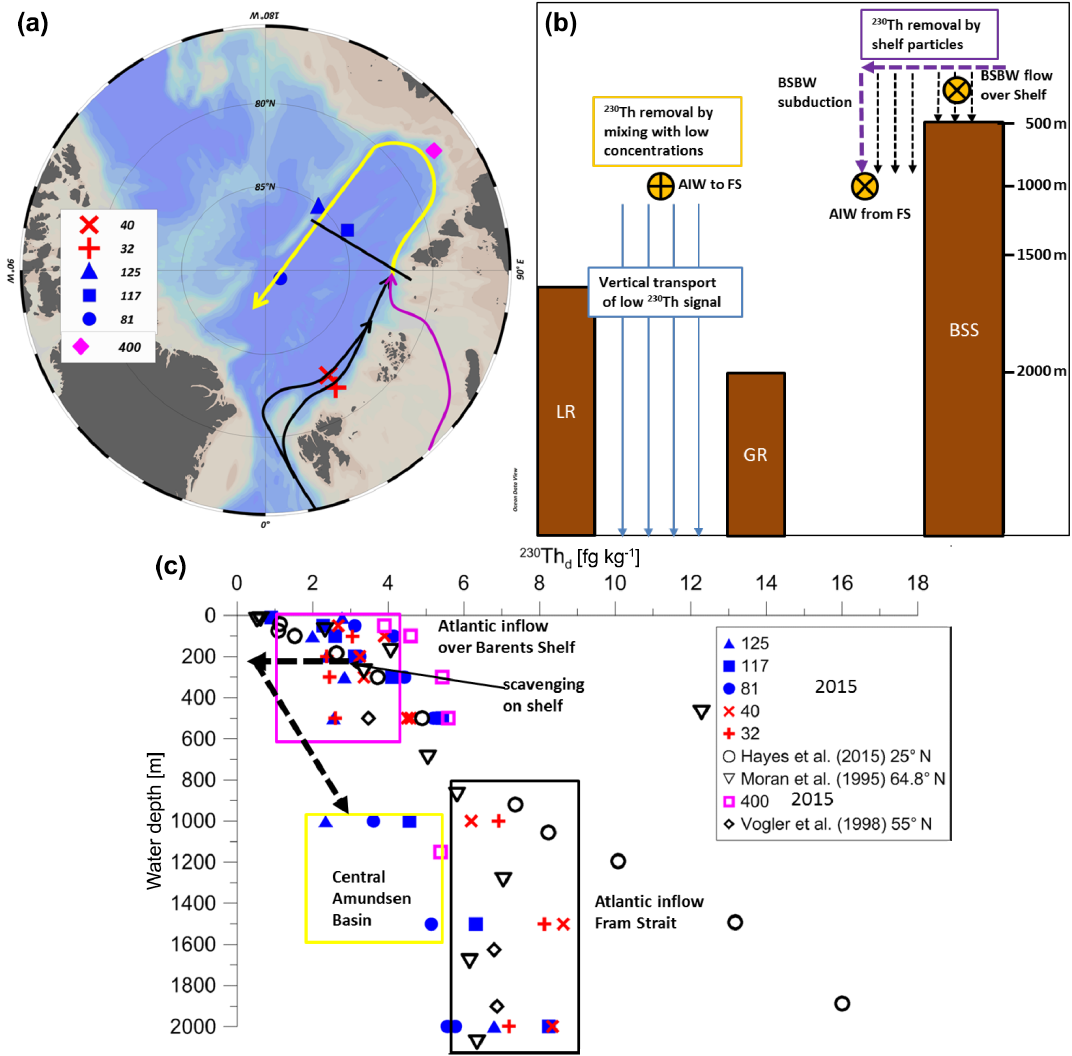
Figure 5. (a) Circulation pathways of Atlantic waters to the central Amundsen Basin. (b) Conceptual drawing of scavenging and mixing of water masses close to St. Anna Trough (black line in a represents the section of b ). LR: Lomonosov Ridge; GR: Gakkel Ridge; BSS: Barents Sea shelf; FS: Fram Strait. (c) Development of dissolved 230 Th concentrations from the North Atlantic to the Amundsen Basin. Atlantic values (open symbols; Hayes et al., 2015; Vogler et al., 1998; Moran et al., 1995) are represented by a deep box flowing in through Fram Strait and a shallow box with lower activities flowing in over the Barents Shelf and exposed to additional scavenging on the shelf (horizontal black arrow) before it is subducted and mixed with deeper Atlantic inflow to form the observed reduced concentrations in the central Amundsen Basin. Stations 32 and 40 (red) are from Gdaniec et al. (2020). Copyright: Schlitzer, R., Ocean Data View, odv.awi.de